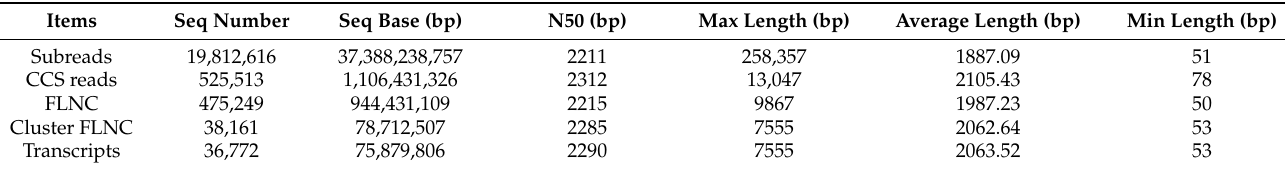
Table 1. The PacBio Sequencing